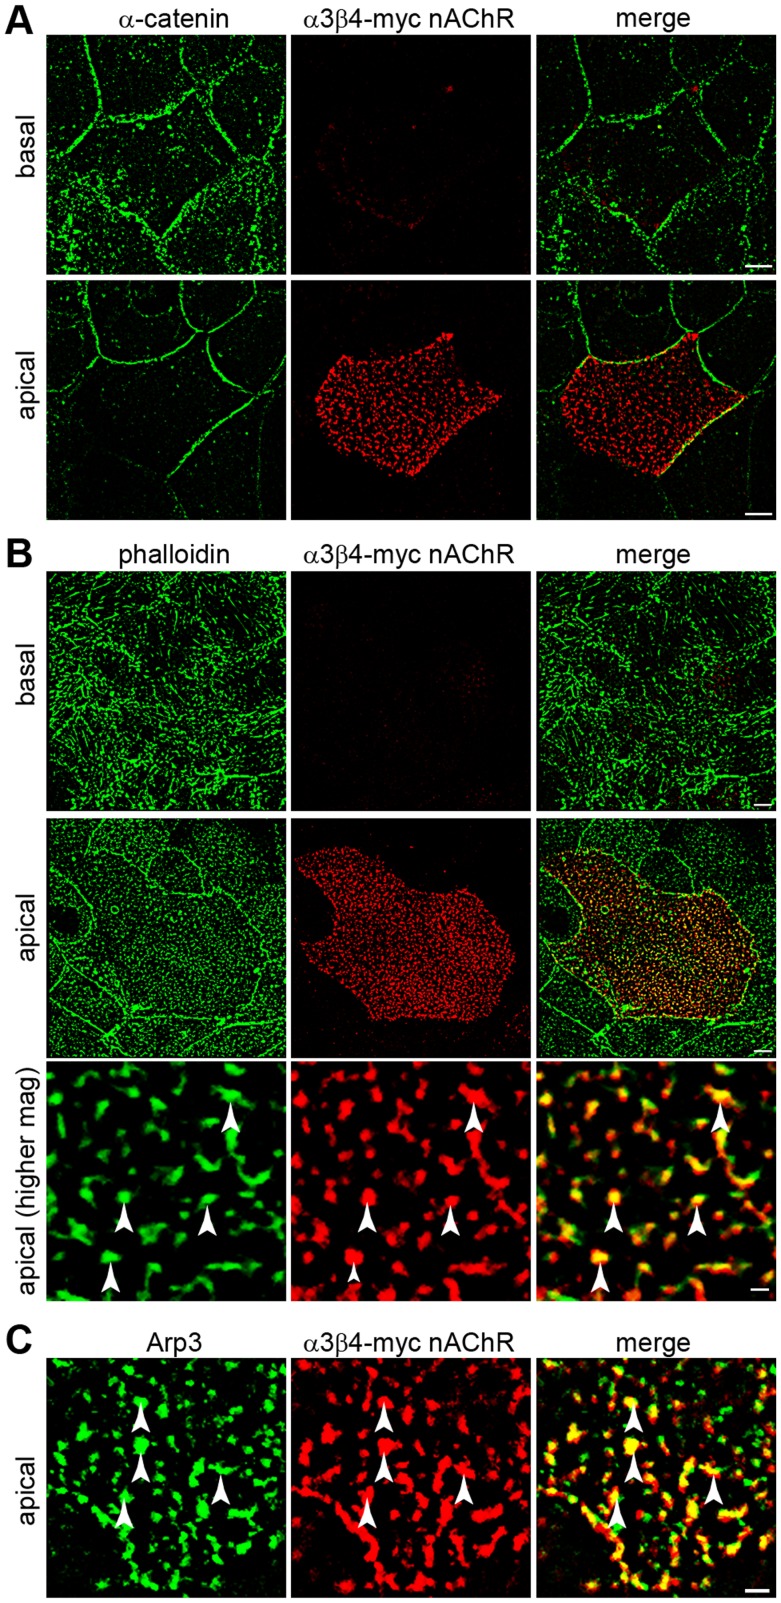
α3β4-myc nAChRs localize to the apical cell surface and colocalize with F-actin and Arp3.Monolayers of Caco-2 cells expressing α3β4-myc nAChRs were fixed, surface labeled with anti-myc antibodies, permeabilized, and colabeled with anti-α-catenin (A), Alexa-488 phalloidin (B), and anti-Arp3 (C) antibodies. A) Deconvoluted confocal images of the basal and apical regions of polarized Caco-2 cells show localization of α-catenin on the basolateral cell membrane while α3β4-myc is exclusively localized to the apical cell surface. B) Deconvoluted confocal images of the basal and apical regions of polarized Caco-2 cells colabeled with Alexa-488 phalloidin show localization of F-actin in both the basolateral and apical cell surface. Higher magnification images of the apical cell surface show colocalization of α3β4-myc nAChRs with F-actin (arrowheads). C) Deconvoluted confocal images of the apical region of Caco-2 cells show colocalization of α3β4-myc nAChRs with Arp3 (arrowheads). Scale bar in A and B, 5 µm; scale bar in B higher magnification and in C, 1 µm.